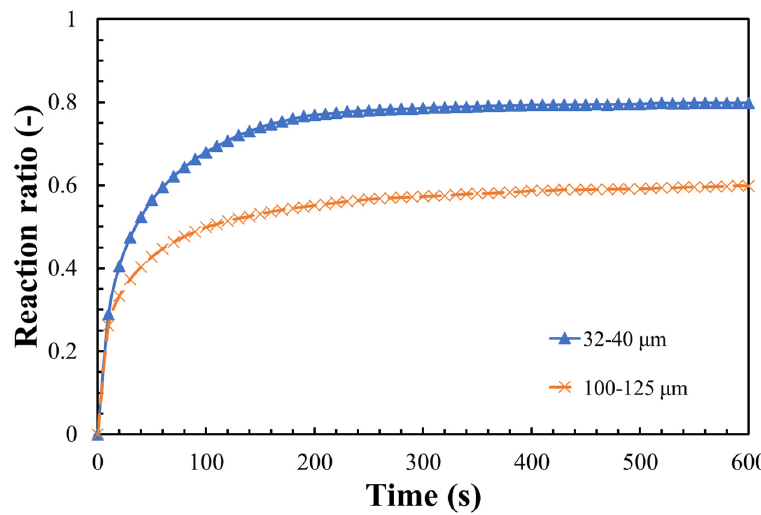
Figure 6. LiOH hydration reaction (temperature 47 °C, steam pressure 5 kPa, and particle size 100– 125 μ m) with that by the thermal gravity method (TG) [27].